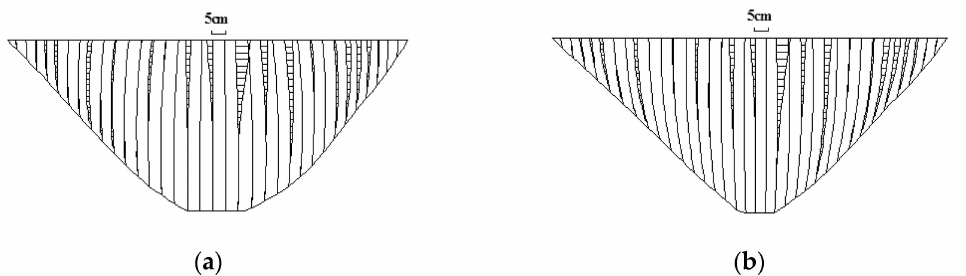
Figure 8. Envelopes of the contraction joint opening using the new standard (cm). ( a ) Upstream surface and ( b ) downstream surface.